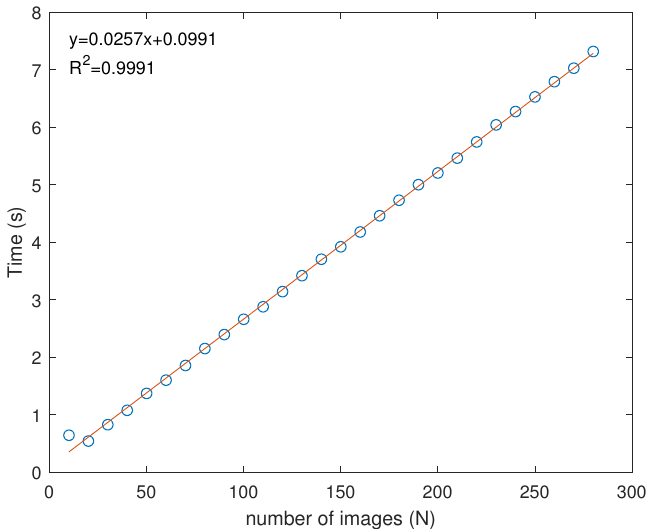
Figure 5. Processing time for a shape from focus data set (1280 × 1024 pixels) reduction to depth-map using the Modified Gray Level Variance (GLVM) focus measure operator in function of the number of images